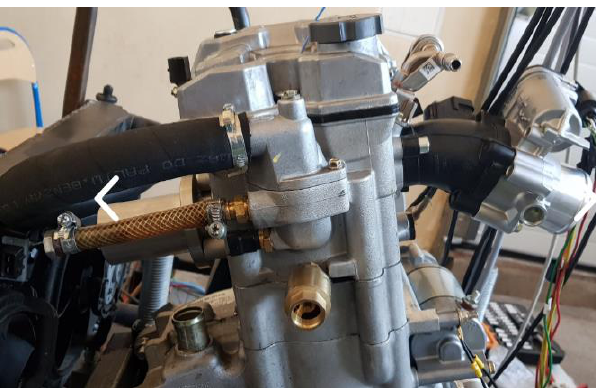
Fig. 7. Cylinder head with an extraction channel with a diameter 5 mm and non-return valve